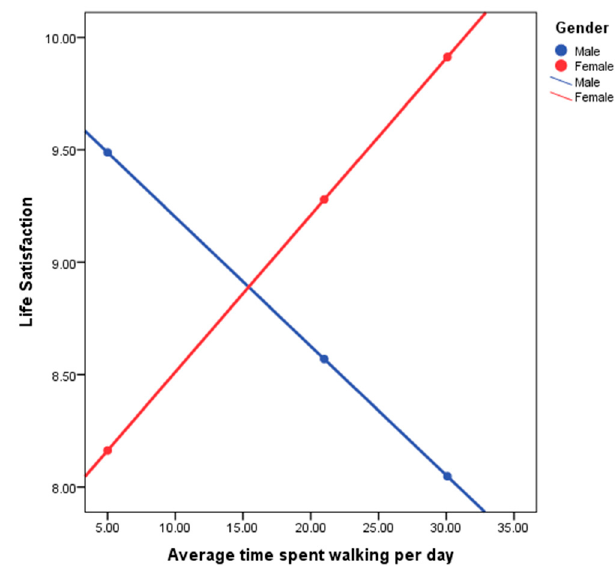
Figure 2. Life satisfaction with average time spent walking per day differentiated by Male/Female.